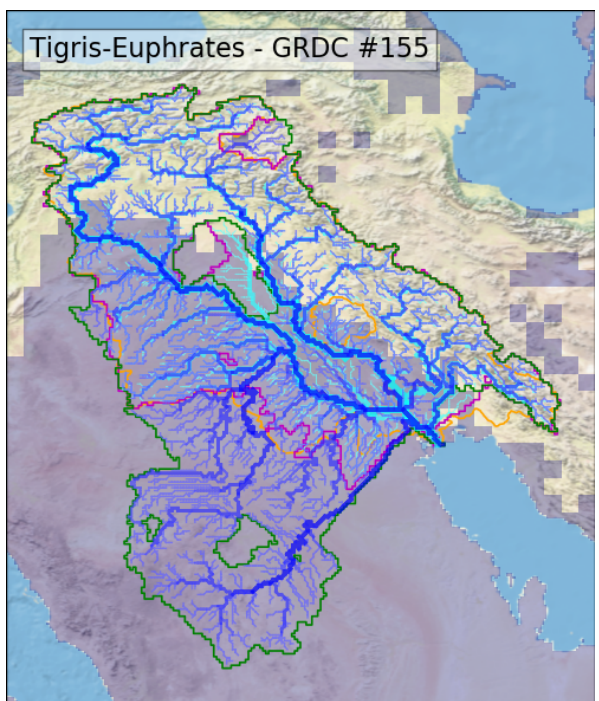
Figure 8. Tigris–Euphrates river system. River networks from the new algorithm and from DRT are drawn in blue and in cyan, re- spectively. Basin boundaries from the new algorithm, from DRT and from GRDC are drawn in green, magenta and orange, respec- tively. The overlapping blue mask represents arid regions. The IoU for this basin equals 14%, which decreases to 8% when the arid regions are removed.